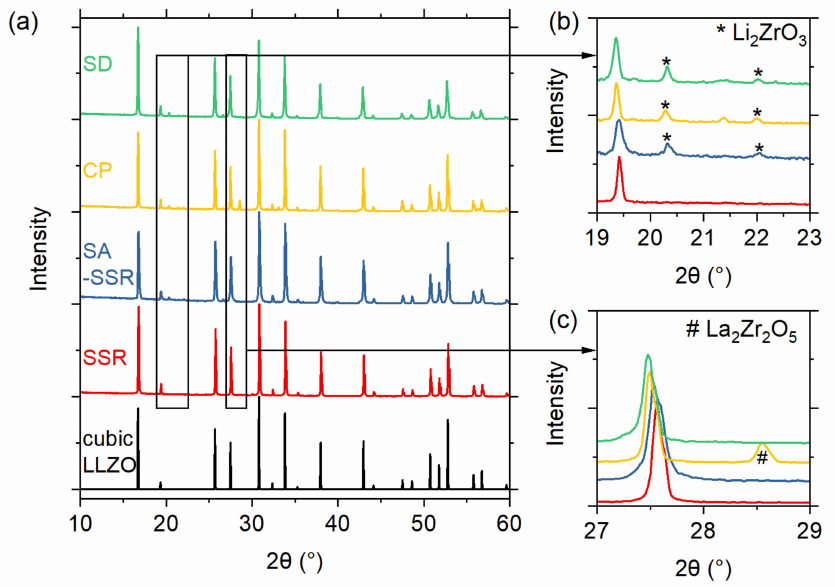
Figure 3. ( a ) XRD pattern of the samples obtained by different synthesis routes (green—SD; blue—CP; red—SASSR; orange—SSR) after the final calcination. The reference pattern for cubic LLZO is shown in black. Small side phases can be observed in the wet-chemical synthesis routes (CP, SASSR, and